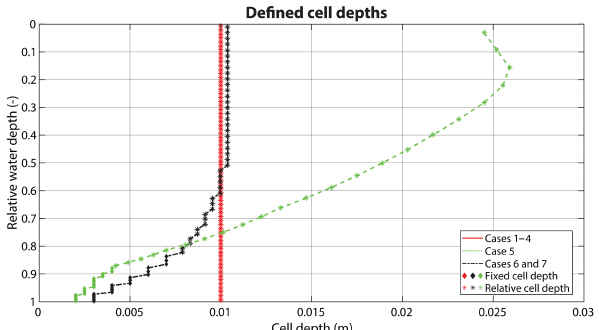
Figure 4. Defined cell depths for Cases 1 to 7. For plotting reasons, the vertical axis displays the depth from the water surface relative to the local water depth. The cell depths that are defined relative to the local water depth (as marked by ∗ ) are displayed for the average water depth in each case